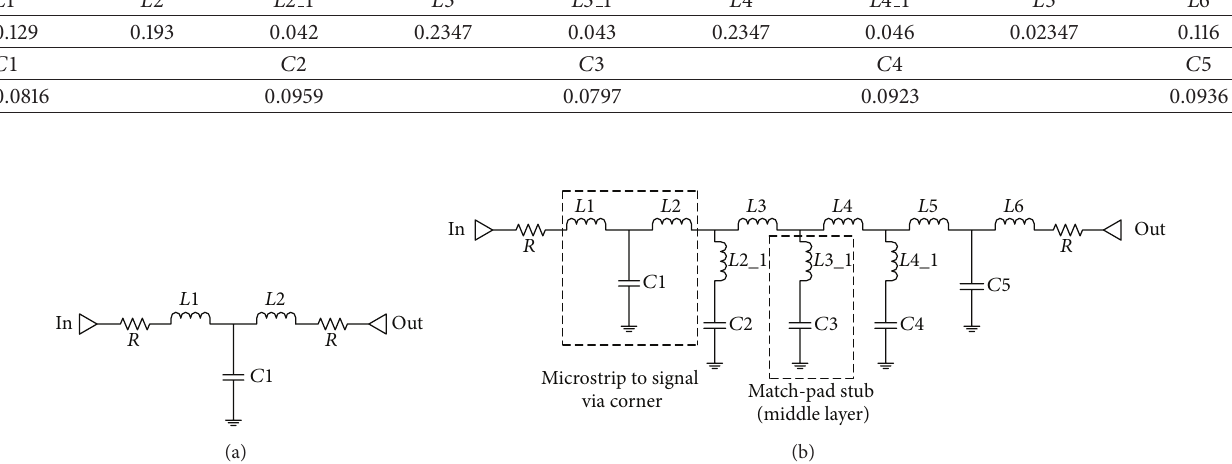
Table 1. The FDTD simulations and measurements in the next section have verified this physics-based equivalent